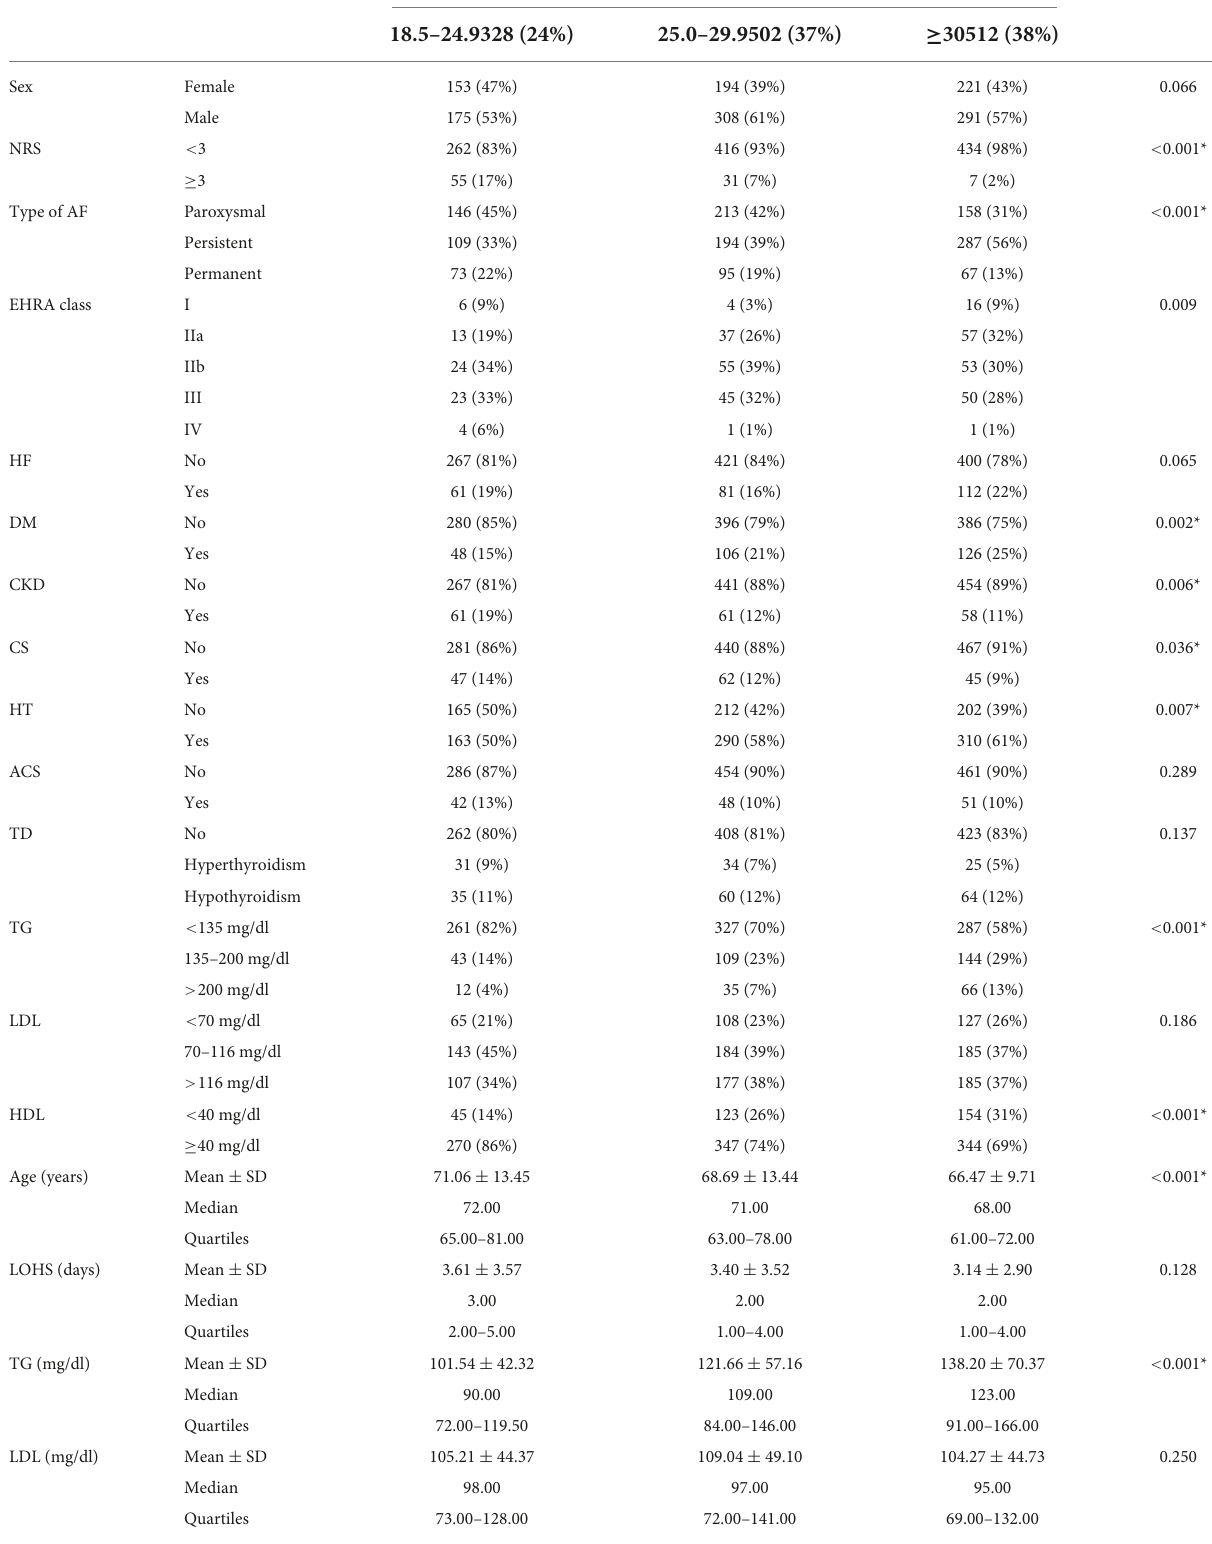
TABLE 2 Comparison of the assessed parameters by BMI status (qualitative and quantitative variables).